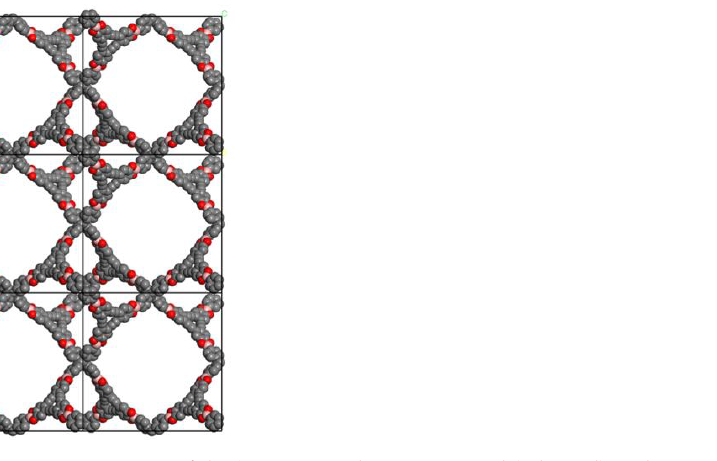
Figure 8. The schematic representation of the bor net topology. Reprinted (adapted) with permission from [30]. Copyright {2016} American Chemical Society.